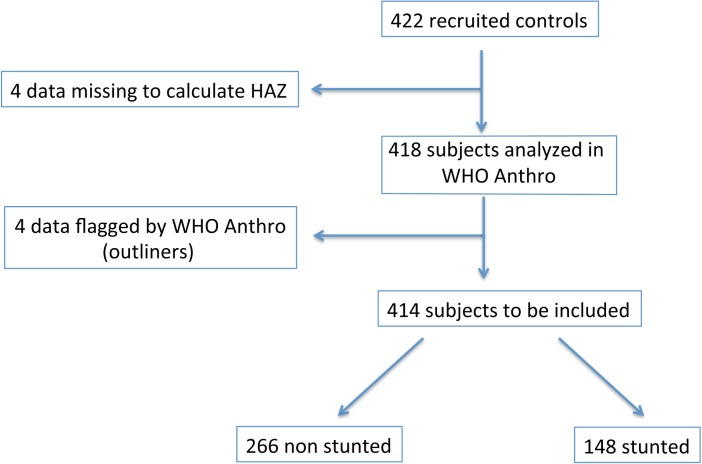
Flow-chart of the subjects included in the study.